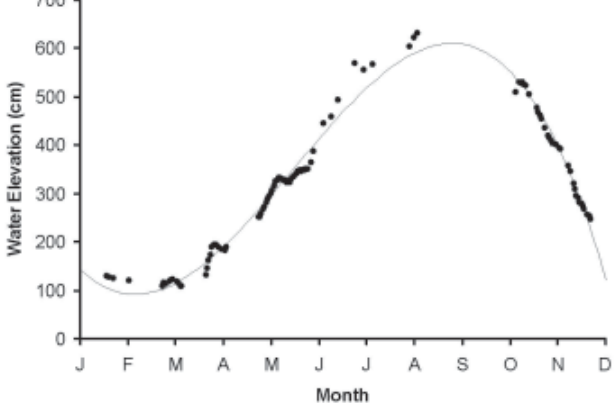
Fig. 2. Annual water level fluctuation of the Cinaruco River during 1999 (modified from Arrington & Winemiller,